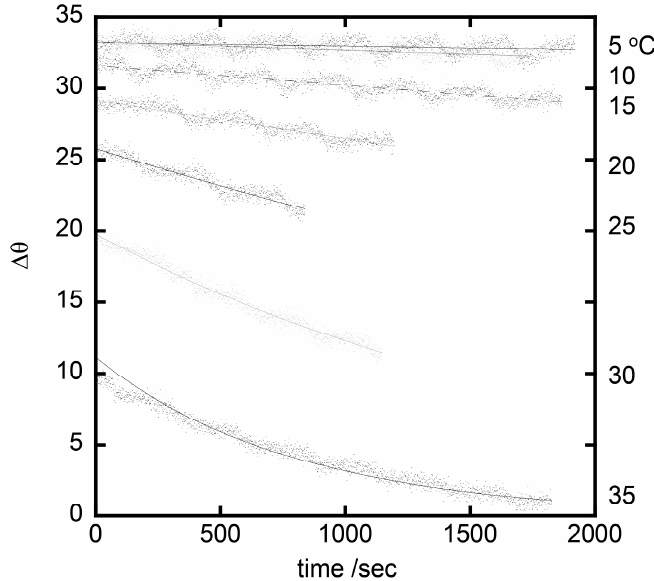
Figure 2. The time change of the electronic circular dichroism (ECD) spectrum of a chloroform solution of [{ Λ -Ru(III)(acac) 2 (taet)} 3 Al(III)] at monitoring wavelength of 318.8 nm. The temperature was 5, 10, 15, 20, 25, 30, and 35 °C from the top to the bottom. Table 1. The unimolecular rate constant of epimerization of [{ Λ -Ru(III)(acac) 2 (taet)} 3 Al(III)] in CHCl 3 and CH 3 OH.